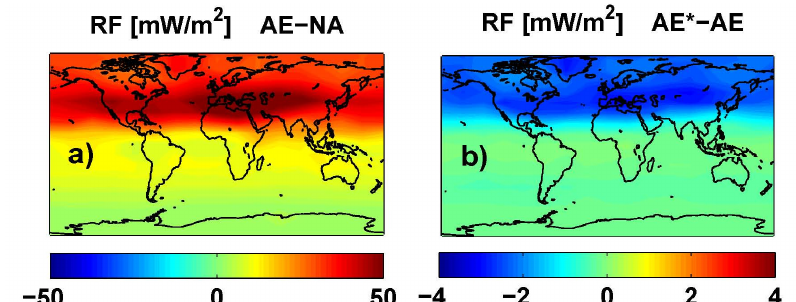
Figure 11. O 3 RF (adjusted) (mW/m 2 ) from an average of ULAQ, CTM2 and CTM3 model results and both radiative transfer codes. Left panel (a) is for AE-NA (globally averaged value: 20.82 mW/m 2 ); right panel (b) is for AE*-AE (globally averaged value: − 0.79 mW/m 2